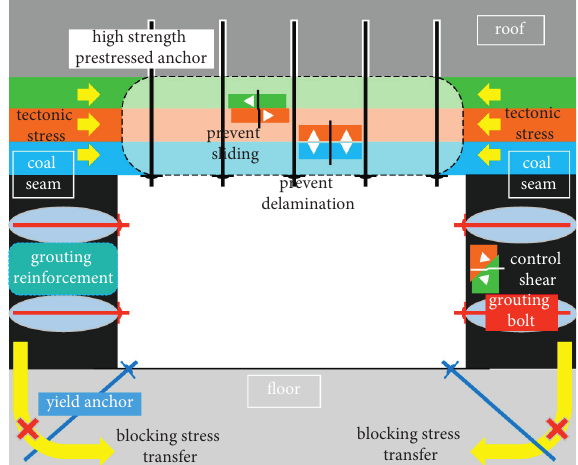
Figure 13: The specific control ideas and countermeasures of roadway surrounding rock